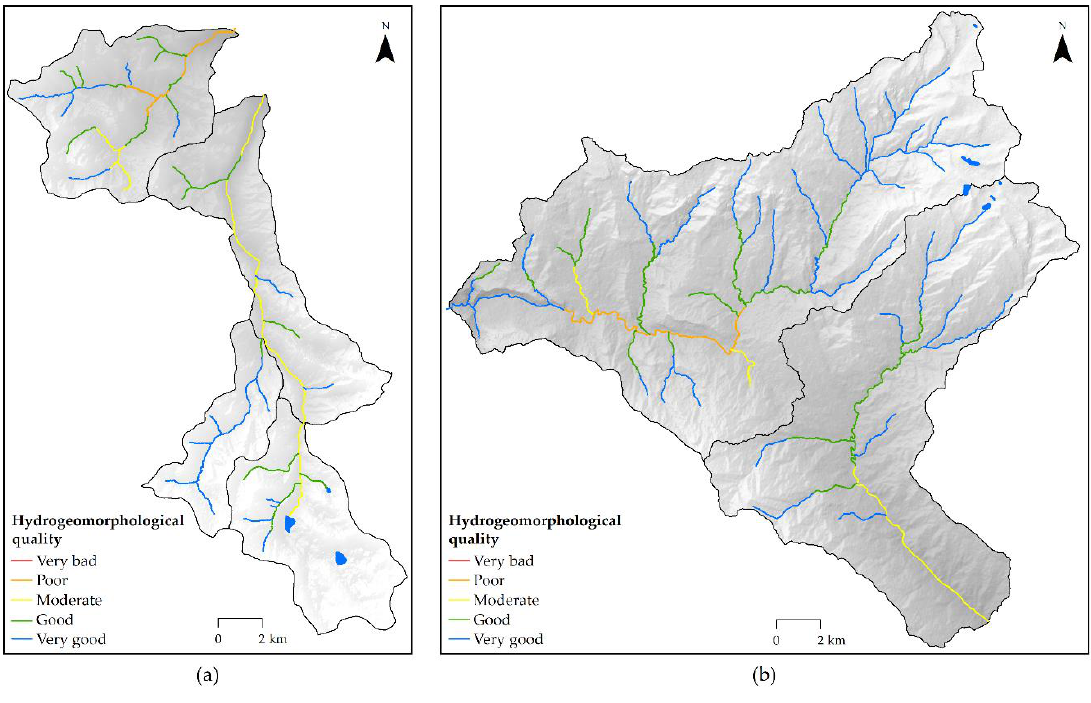
Figure 8. Hydrogeomorphological quality (IHG) of the ( a ) four HAL-MWs in Leimebamba and ( b ) two HAL-MWs in Molinopampa (Amazonas, Peru). Table 15. Hydrogeomorphological quality (IHG) assessments of the four HAL-MWs in Leimebamba and two HAL-MWs in Molinopampa (Amazonas, Peru).